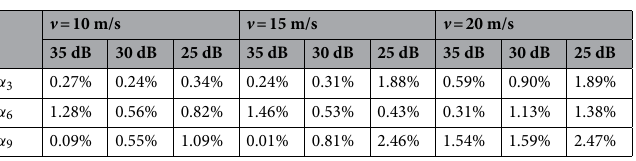
Table 3. Damaged element stiffness identification errors with different speeds and different